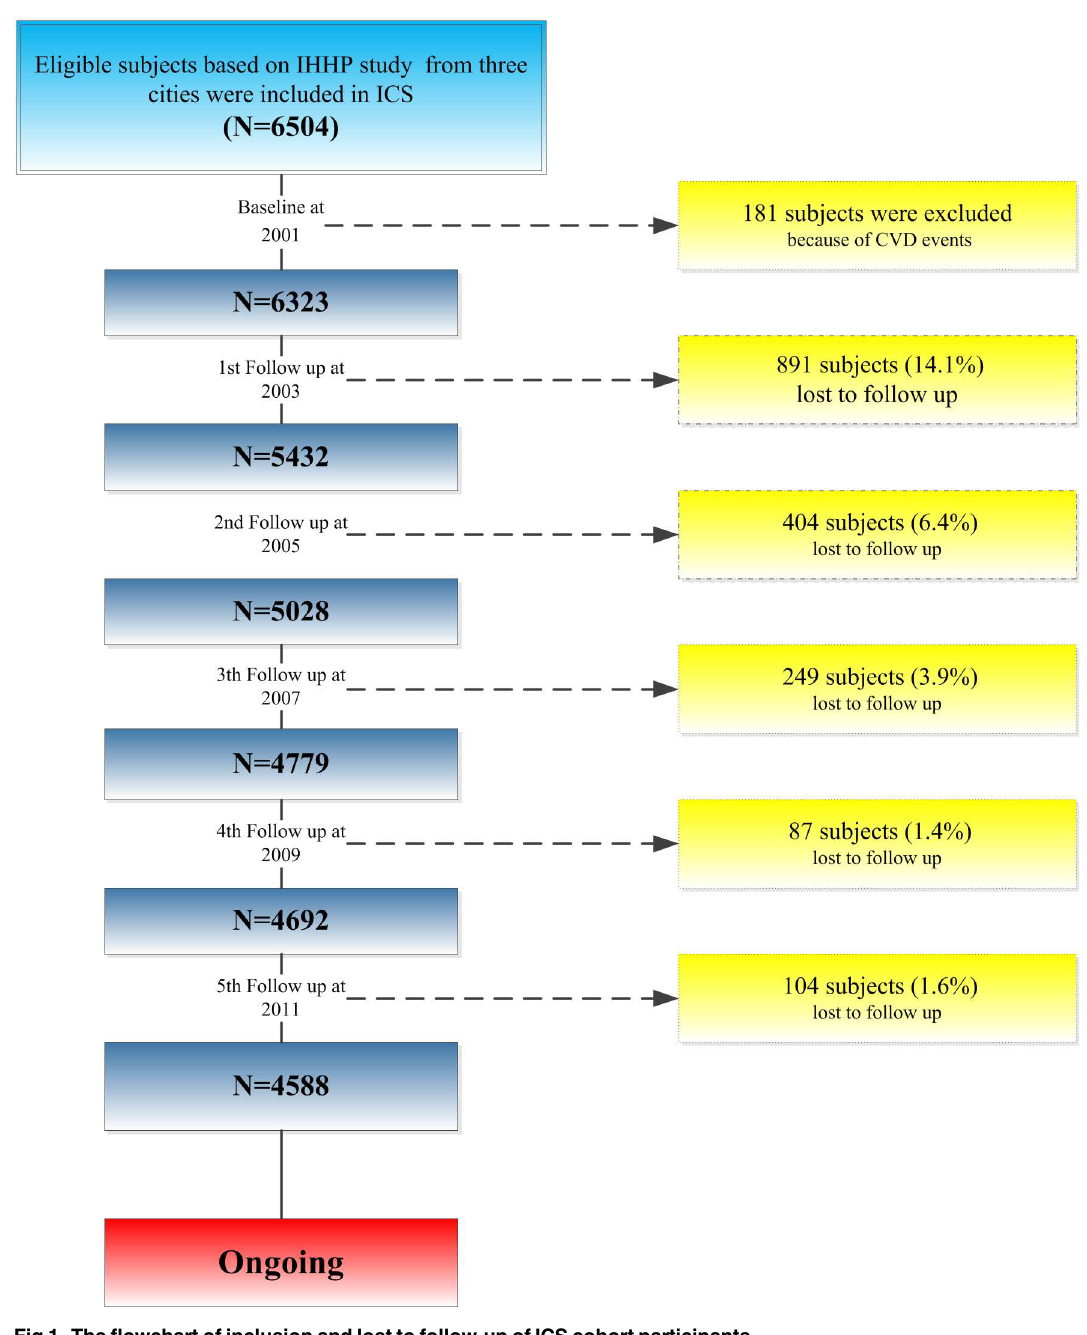
Fig 1. The flowchart of inclusion and lost to follow-up of ICS cohort